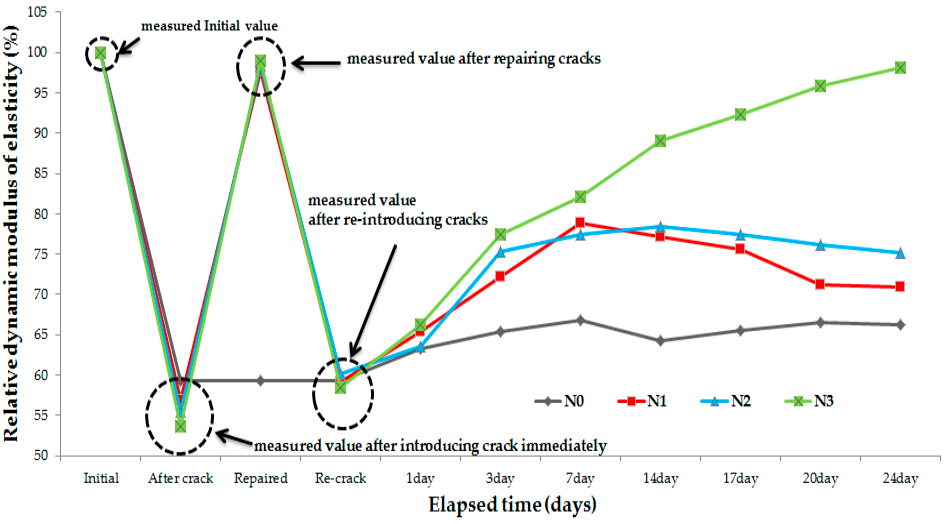
Figure 12. Results of the relative dynamic modulus of elasticity.